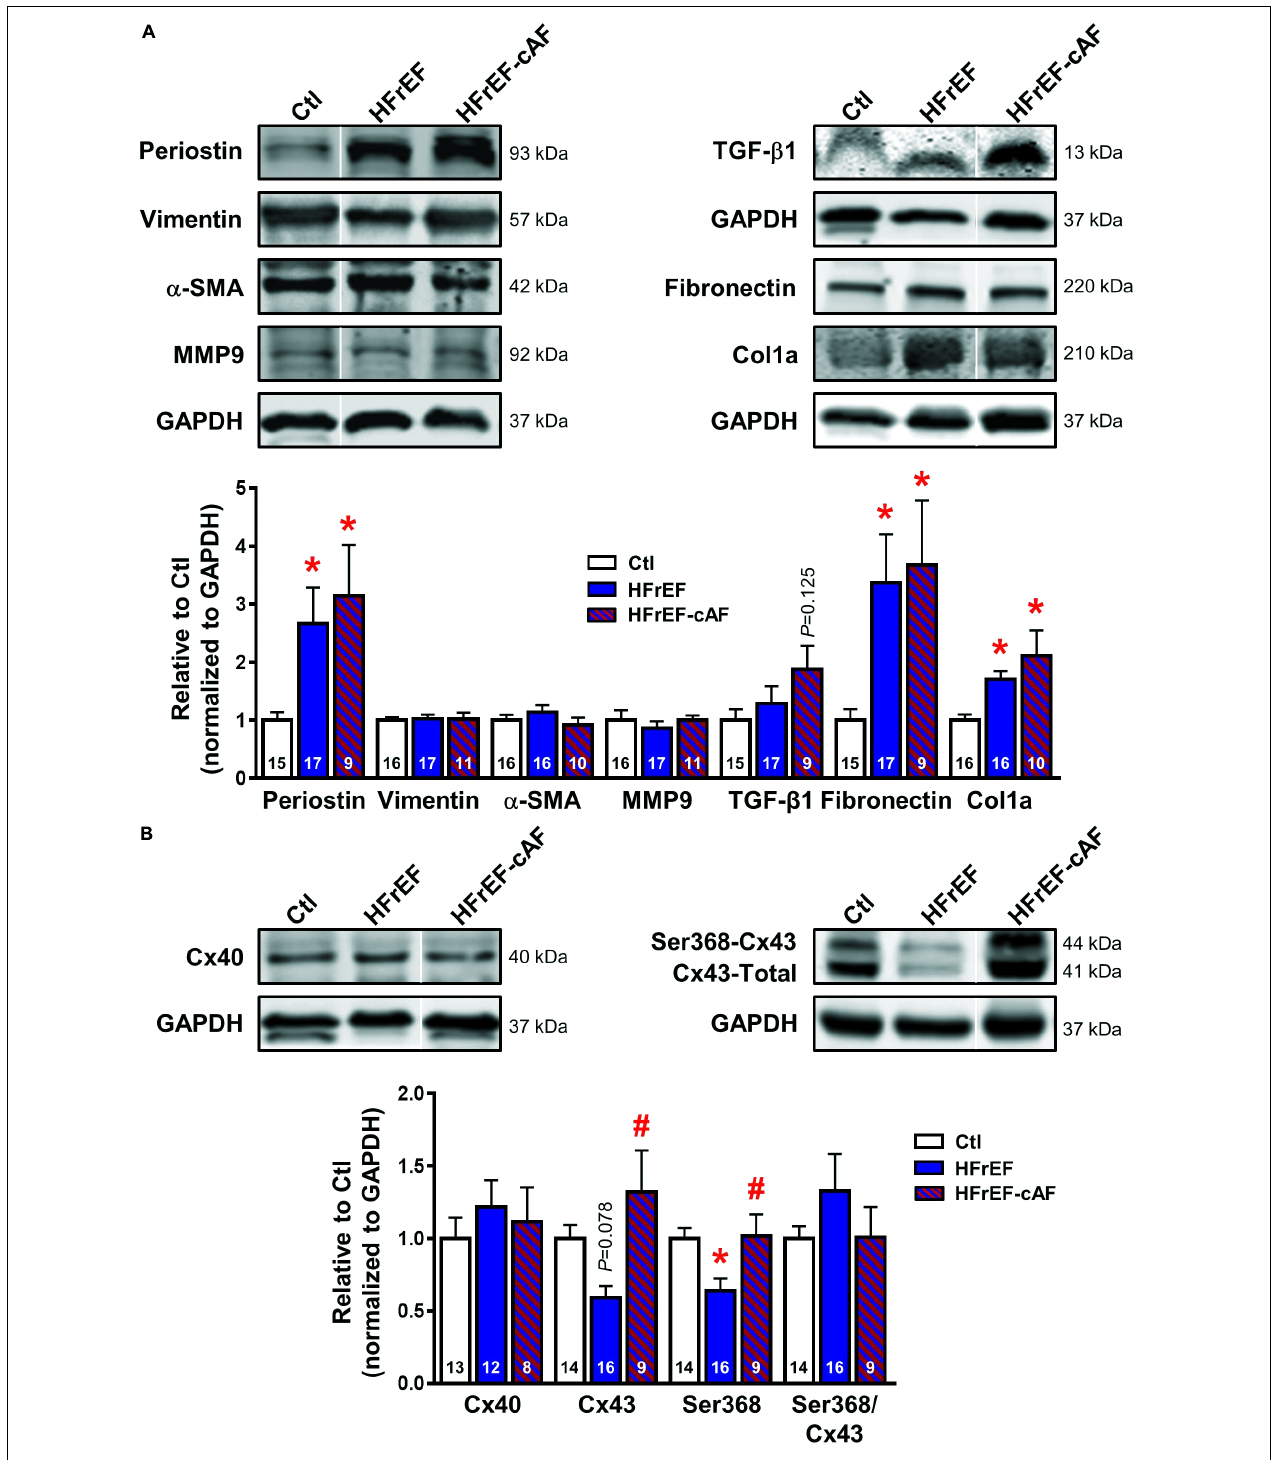
FIGURE 1 | Atrial profibrotic and connexin remodeling. (A) Representative Western blot examples (top) and quantification of protein expression (bottom; mean ± SEM) of periostin, vimentin, α -smooth muscle actin ( α -SMA), matrix metallopeptidase 9 (MMP9), transforming growth factor- β 1 (TGF- β 1), fibronectin and collagen 1 α (col1a) in right-atrial tissue homogenates from Ctl (white bars), HFrEF (blue bars) or HFrEF-cAF (red/blue-striped bars) patients. Vertical white lines separate non-adjacent lanes on the same blot. (B) Representative Western blot examples (top) and quantification of protein expression (bottom; mean ± SEM) of total connexin-40 (Cx40), total and Ser368-phosphorylated connexin-43 (Cx43). GAPDH was used as loading control and is shown for the samples used for Western blots of periostin, vimentin, α -SMA and MMP9, for TGF- β 1, and for fibronectin and col1a. Numbers in bars indicate number of patients. ∗ indicates P < 0.05 vs. Ctl, # indicates P < 0.05 vs. HFrEF.